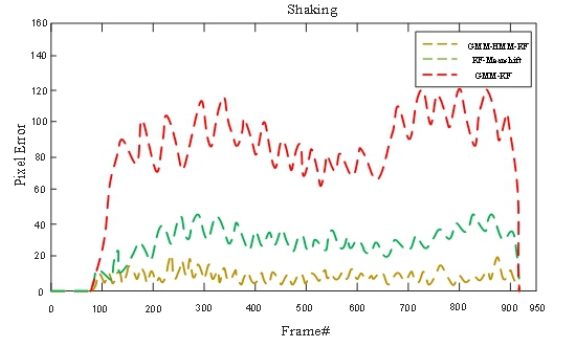
Fig. 17. The average pixel error of the three algorithms in